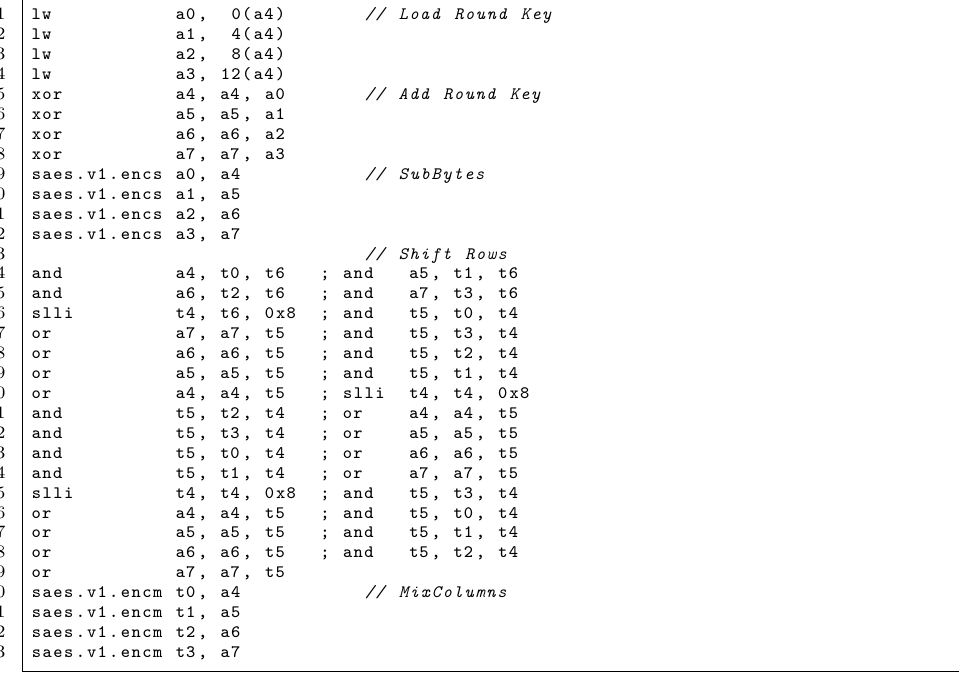
Figure 7: An AES encryption round implemented using V 1 .